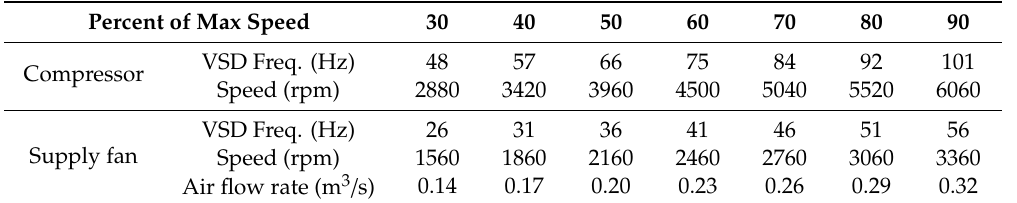
Table 2. The simulation range of compressor and supply fan speeds.